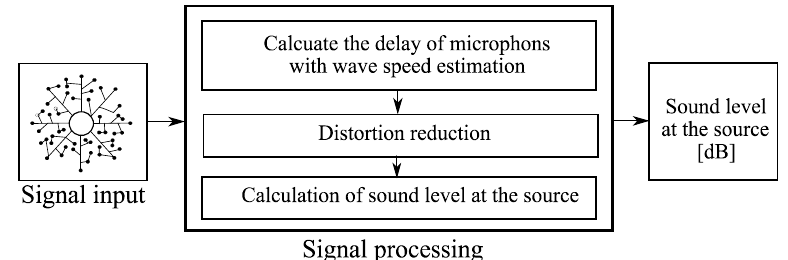
Figure 7. Simplified diagram of acoustic camera signal analysis.